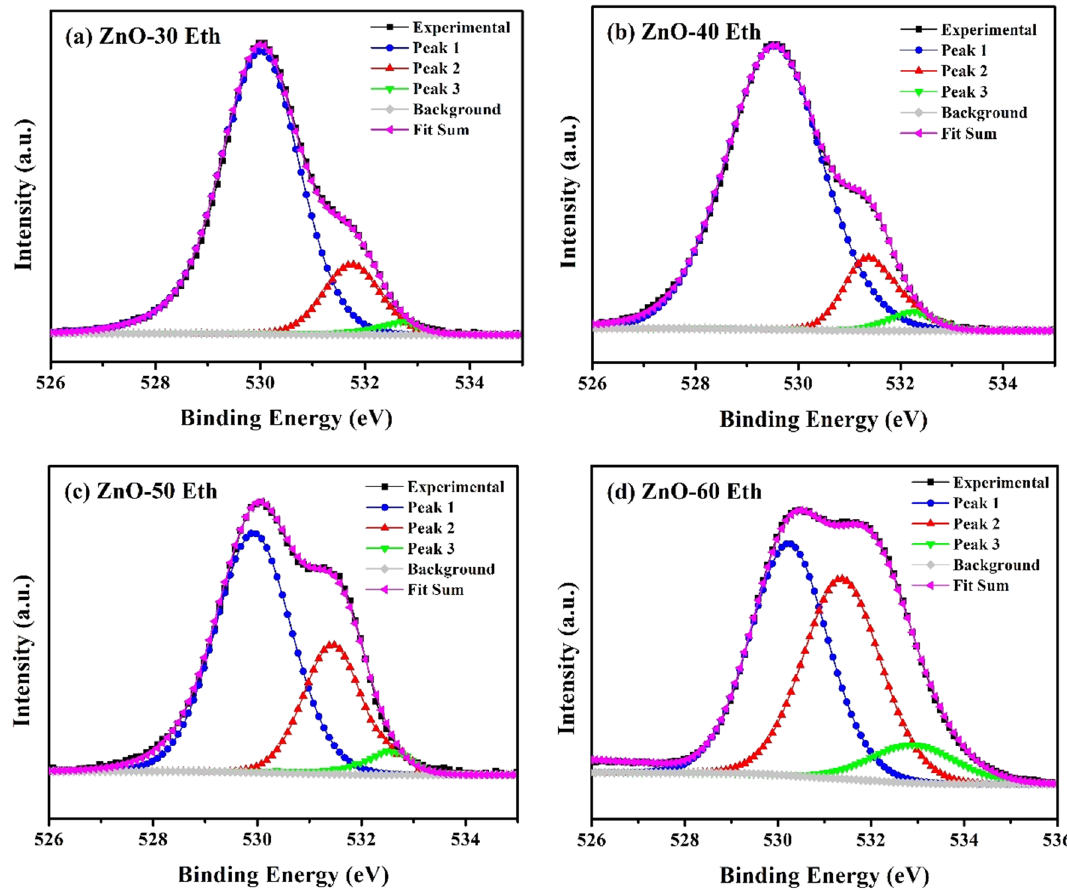
Figure 6. XPS O1s spectra of the ( a ) ZnO-30 Eth, ( b ) ZnO-40 Eth, ( c ) ZnO-50 Eth and ( d ) ZnO-60 Eth thin